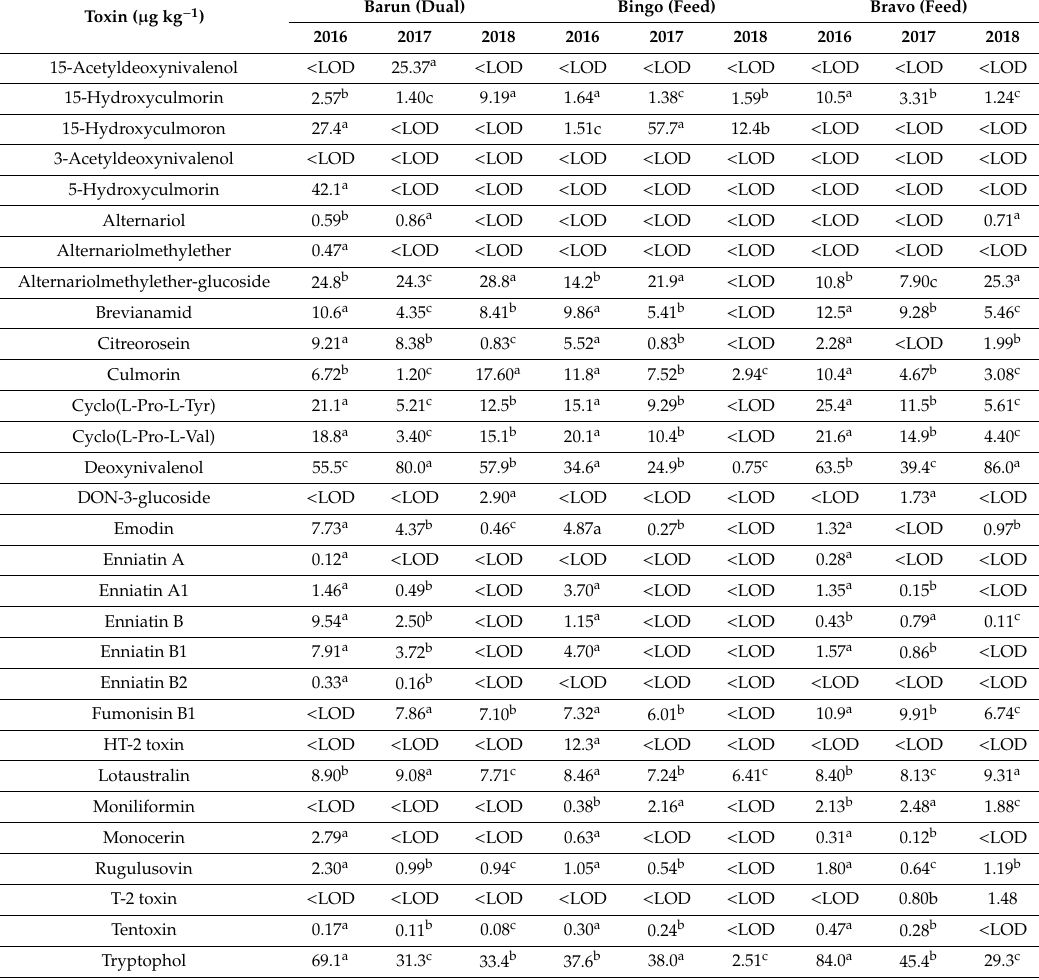
Table 3. Concentrations of other positively identified mycotoxins and fungal metabolites in barley